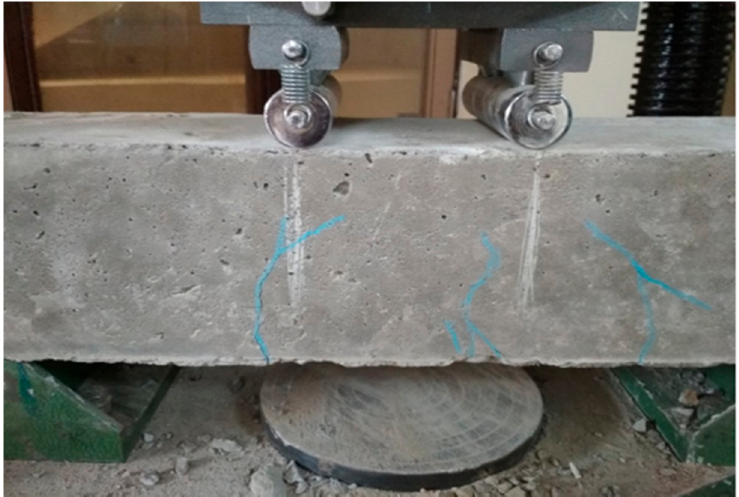
Figure 6. Loading setup on beam.